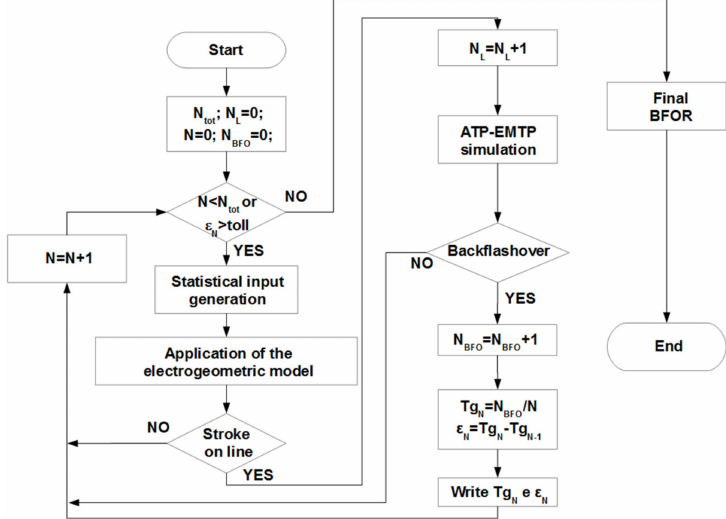
Figure 3. Flowchart of the Monte Carlo